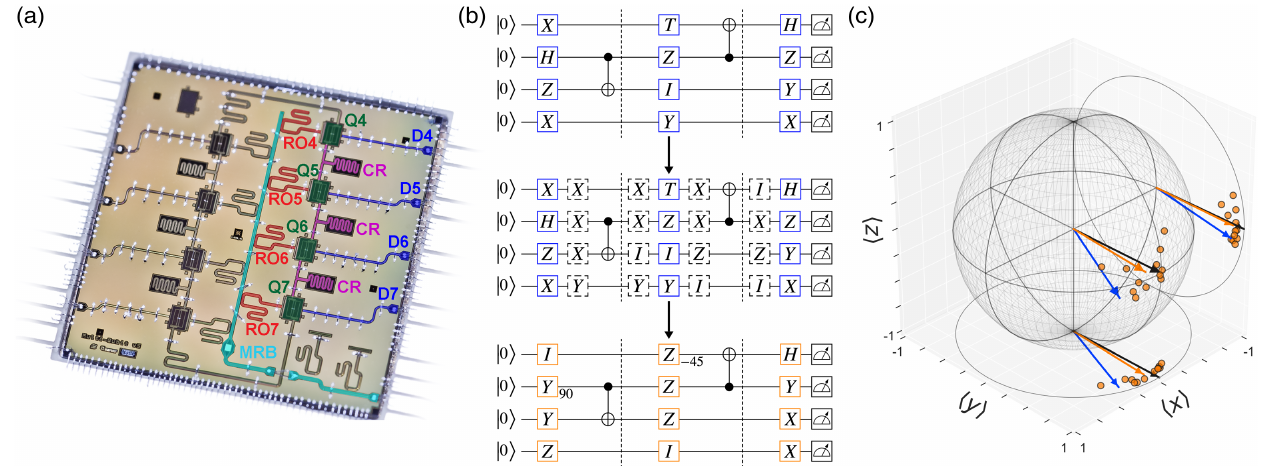
FIG. 1. Experimental realization of noise tailoring via randomized compiling on a superconducting quantum processor. (a) False- colored micrograph of our eight-qubit superconducting quantum processor. In this work, we use four transmon qubits [33] (green) with independent microwave control lines (blue). Two-qubit cross-resonance [34 – 37] gates are mediated by coupling resonators (CR, purple) between nearest neighbors. The qubits are simultaneously measured via dispersive coupling [38] to independent readout resonators (RO, red) coupled to a multiplexed readout bus (MRB, cyan). (b) Randomization of a quantum circuit. The bare circuit (top), split into K interleaved cycles of easy and hard gates (separated by dashed lines), (middle) is converted into a logically equivalent circuit by inserting random single-qubit twirling gates between each easy and hard cycle, inverting them in the following cycle, and (bottom) then compiling the twirling gates into a new easy-gate cycle. (c) Experimental single-qubit state-tomography results demonstrating noise tailoring. The black vector is the ideal (noiseless) final state of the qubit, but coherent errors cause an over-rotation in the measured state (blue vector). The orange vector represents the final state of the combined distribution of N ¼ 12 randomizations (orange data points), which has a lower purity because of the tailored stochastic noise. RC significantly mitigates the impact of coherent errors, as indicated by a reduction 0 . 170 ð 8 Þ to d 0 . 029 ð 2 Þ in the fjþi ; j − ig basis, from d 0 . 069 ð 4 Þ to d 0 . 060 ð 1 Þ in in the TVD from d TV ; bare ¼ TV ; RC ¼ TV ; bare ¼ TV ; RC ¼ 0 . 073 ð 8 Þ to d 0 . 008 ð 2 Þ in the fj 0 i ; j 1 ig (computational) basis. This improvement is the fjþ i i ; j − i ig basis, and from d TV ; bare ¼ TV ; RC ¼ not captured by the bare ( F ¼ 0 . 862 ) and RC ( F ¼ 0 . 879 ) state fidelities, which are approximately